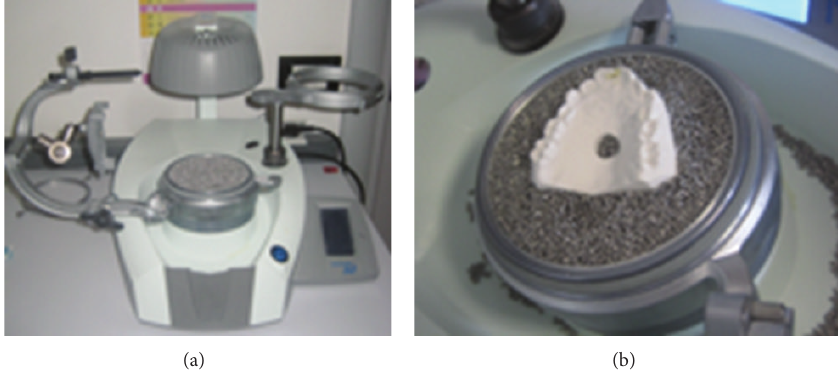
Figure 2: Plaster model in the positive pressure thermoformer.